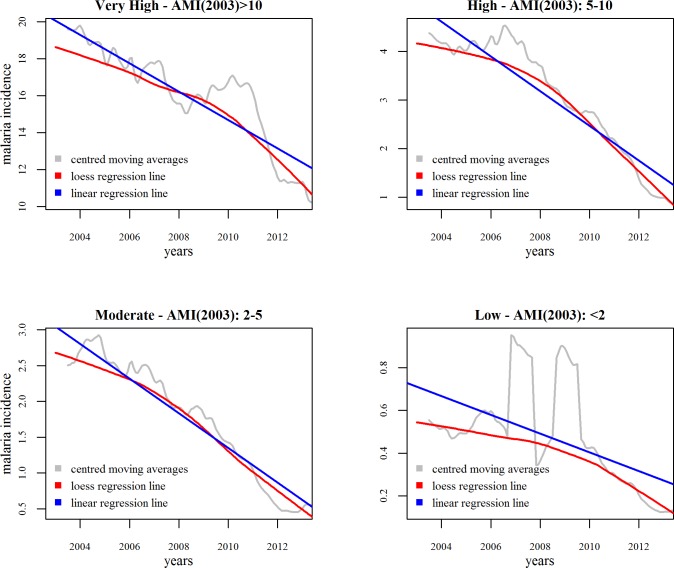
Trends in malaria in the districts stratified by their baseline malaria burden (2003), Odisha.